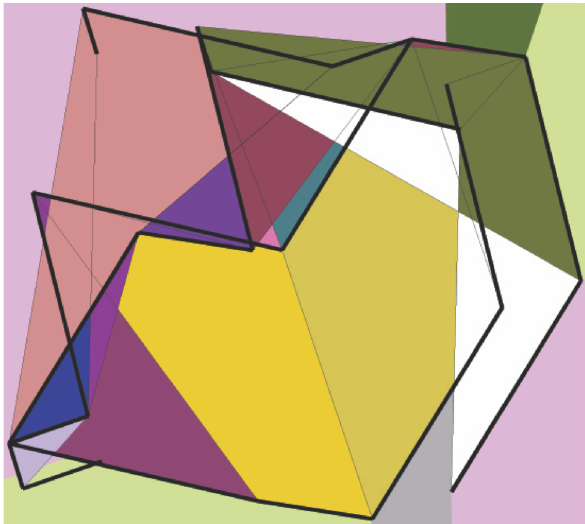
Figure 2 | Manfred Mohr, P-707-E , 2000, Courtesy of the